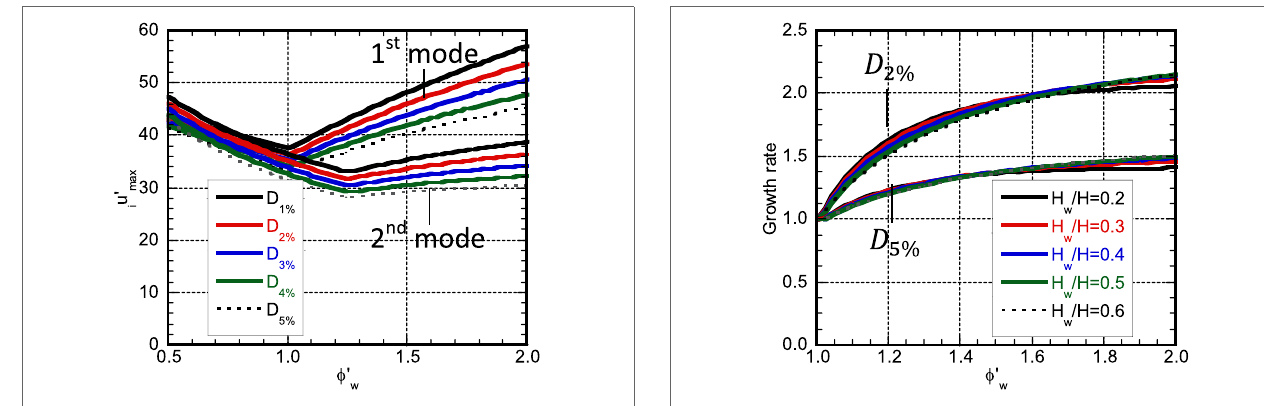
FIGURE 10 | Maximum story drift angle under various damping quantities ( H w / H :0.4).